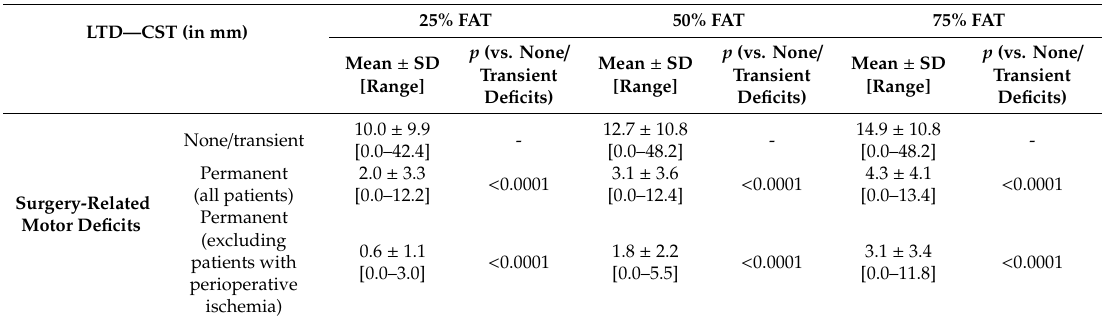
Table 3. Lesion-to-tract distances (LTDs) for surgery-related motor